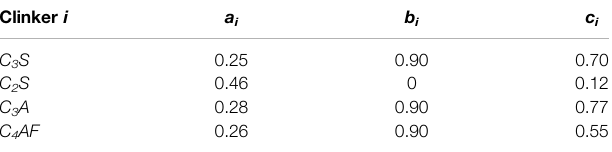
TABLE 1 | Constants in the Avrami equations (Taylor,